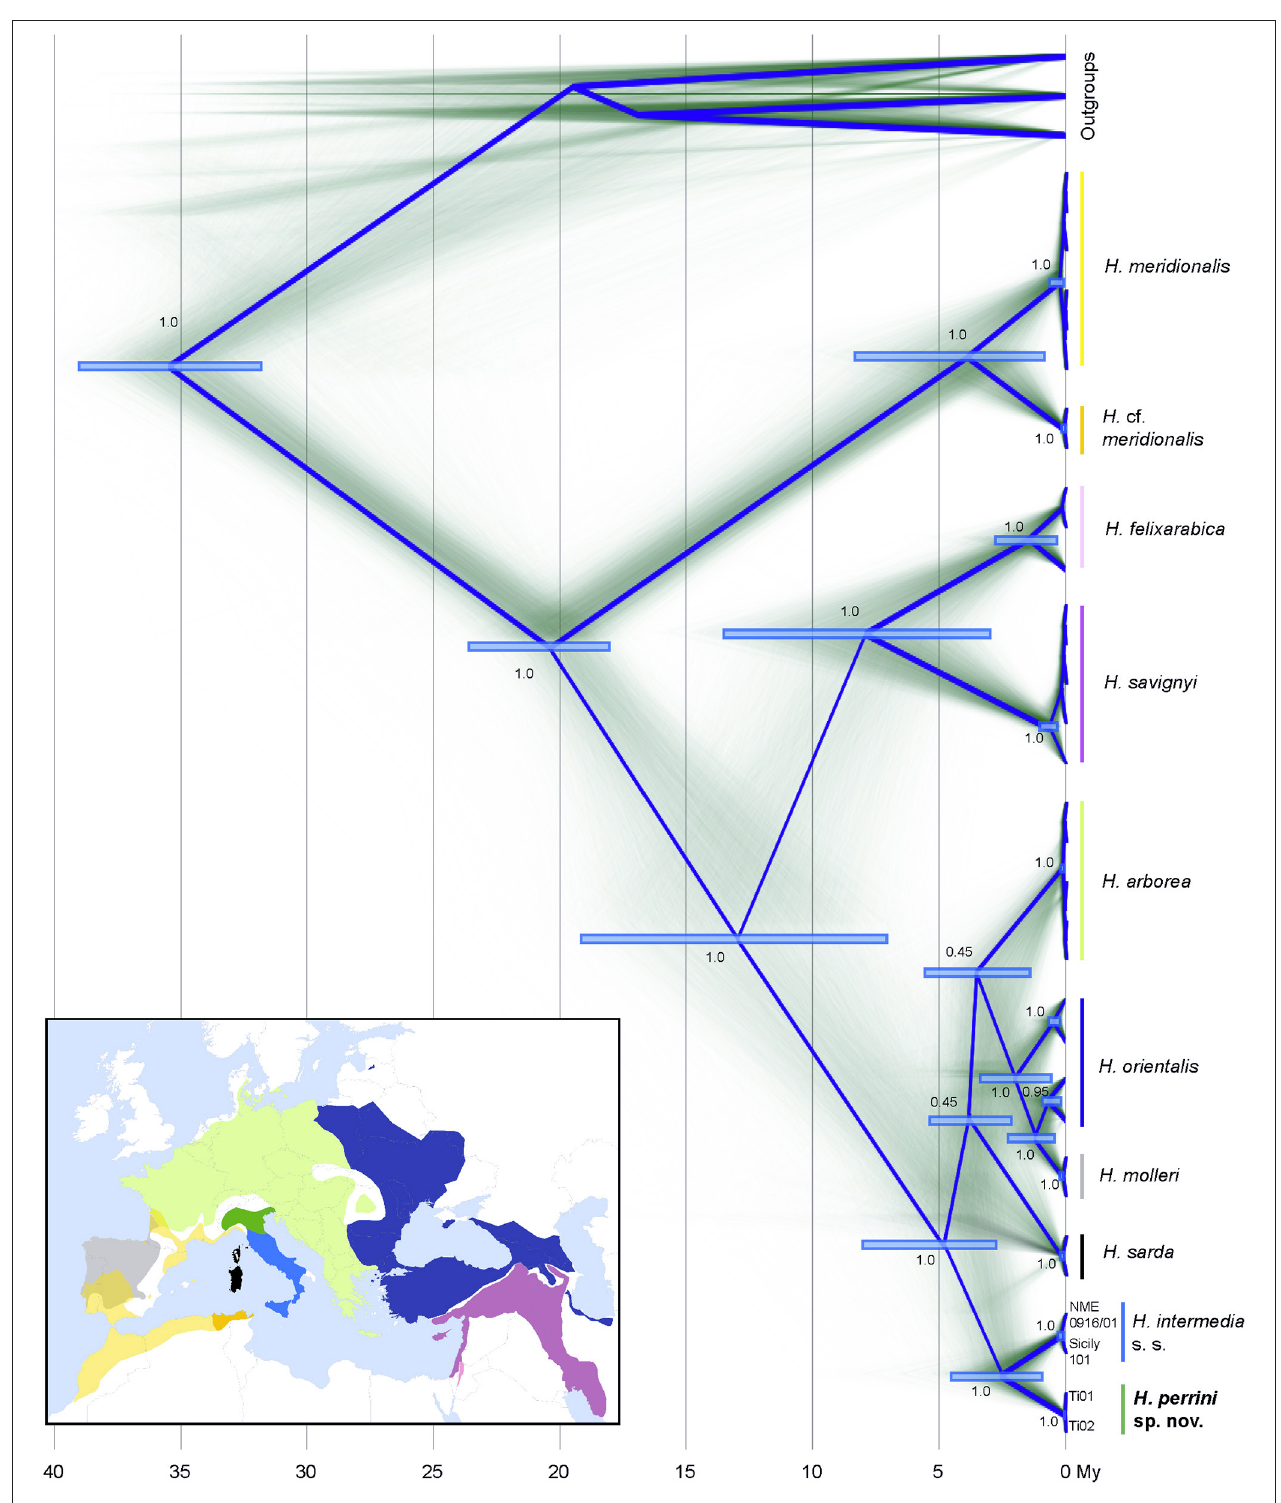
FIGURE 1 | Time-calibrated phylogeny of mitochondrial sequences from cyt-b (840 bp) and COI (766 bp). Clock rates were nearly identical between markers (2.5e − 2 substitutions/site/My). Diffuse lines show branches of each of the sampled trees, summarized by the root canal (blue framework). For major nodes, the Bayesian posterior probabilities and confidence intervals of divergence times are indicated. Species distributions use the color codes shown on the tree. The map was built in QGIS 2.18 using map layers from ESRI and the IUCN red list (adapted by Dufresnes, 2019). Hyla japonica , H. cinerea and H. squirella were used as outgroups ( Table S1A